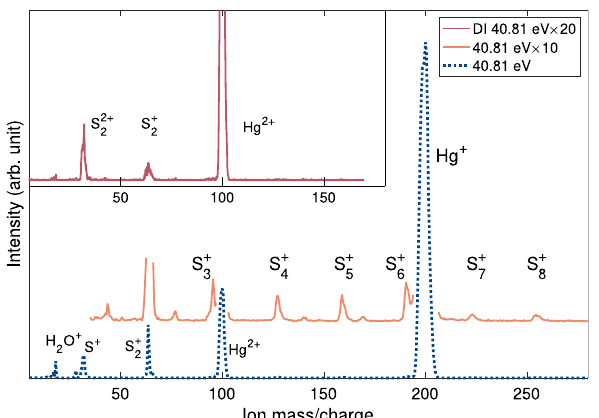
Figure 1. Full mass spectrum of the vapour of heated HgS at 40.81 eV (dashed blue line), with × 10 magnification (solid orange line), and the spectrum of ions extracted in coincidence with two electrons (solid red line). The spectra are dominated by Hg, followed by S 2